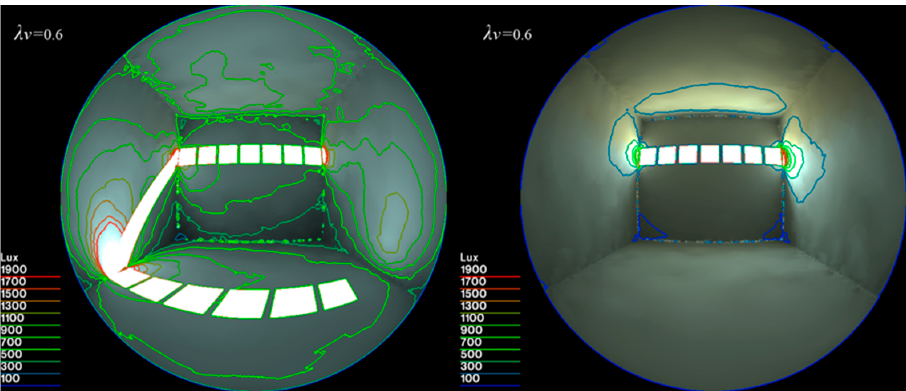
Figure 16. Radiance rendered views for λ v = 0.6 in the south- and west-facing orientations at 12:00 p.m. 21 December (standard meteorological year).